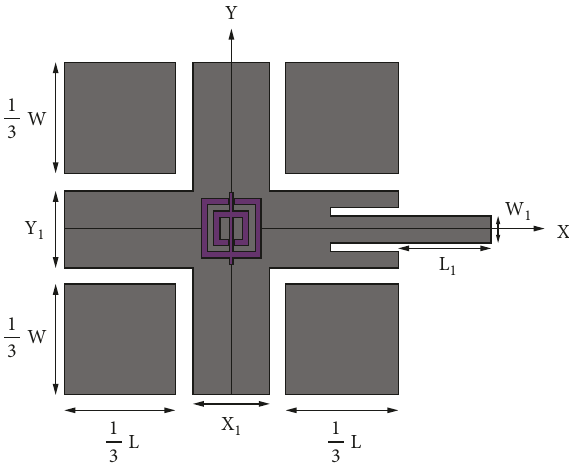
Figure 8: The proposed metamaterial fractal antenna.